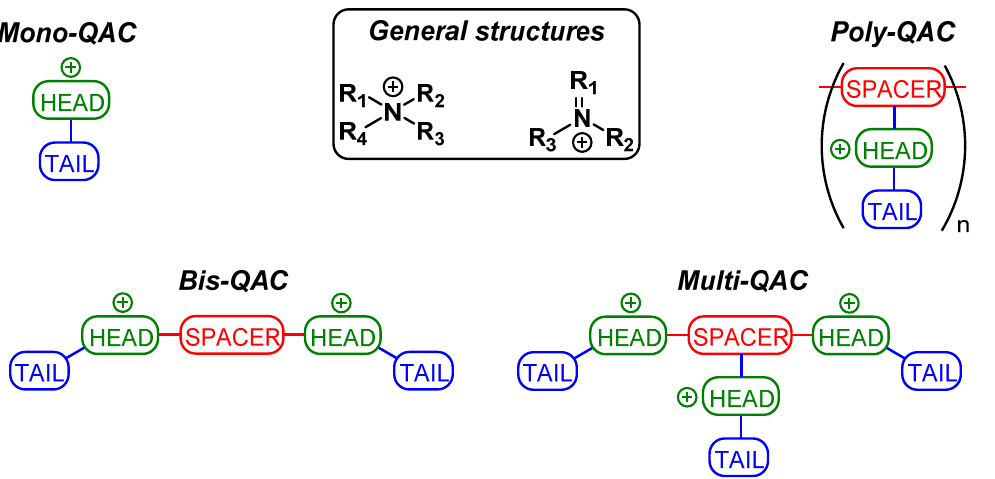
Figure 1. General structures and types of QACs.